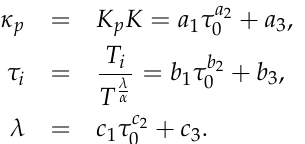
Figure 3. Determination of κ p tuning rule for FOPID ( M t Solid line is the interpolating function (11).